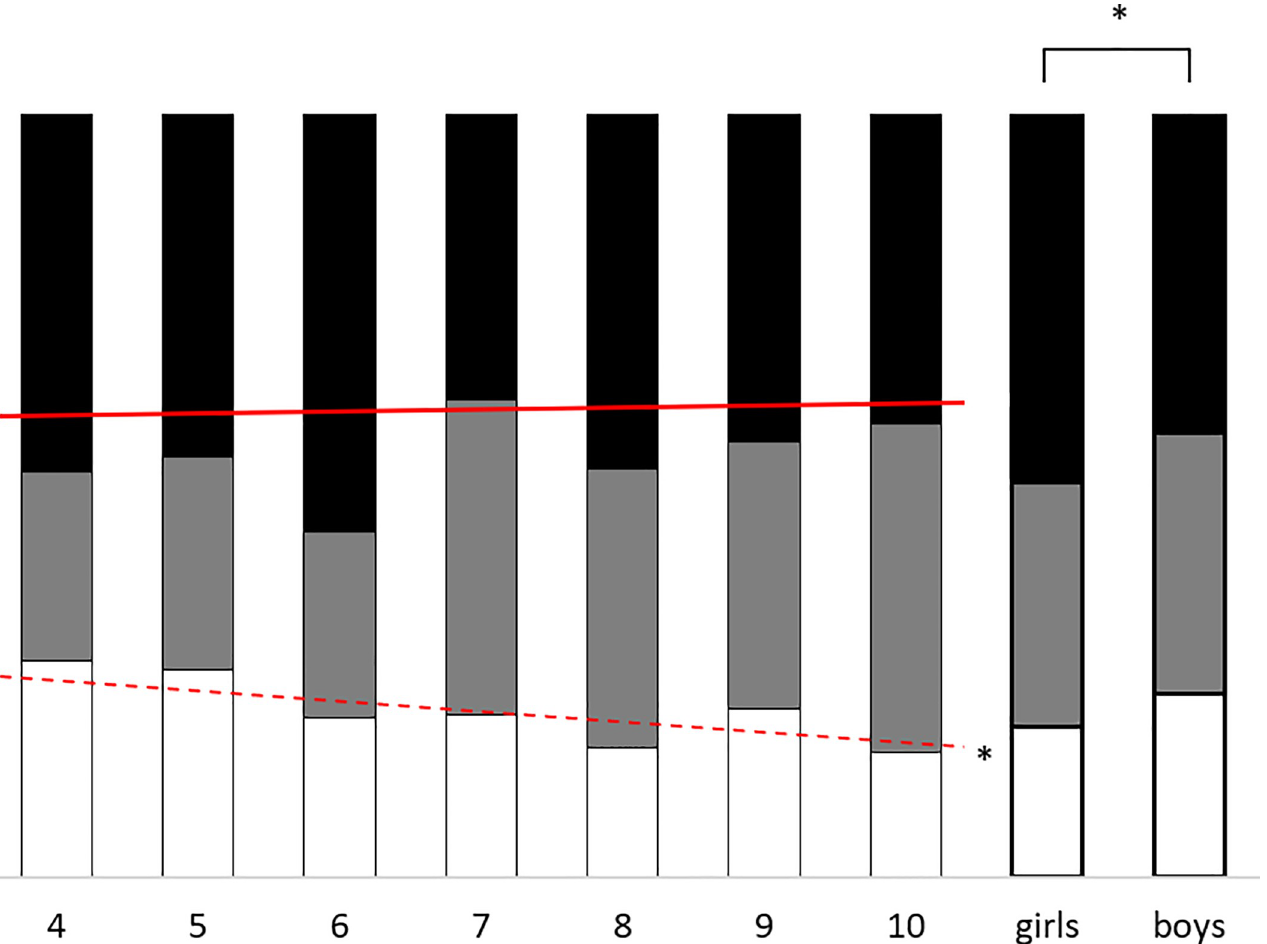
Fig 2. Summary of children’s overall levels of moral concern (collapsed over all 24 entities) across age groups and gender. White bars indicate the proportion of ‘not caring at all’ responses; grey bars indicate the proportion of ‘caring a little’ responses, and black bars indicate the proportion of ‘caring a lot’ responses. The solid red line indicates the (non-significant) linear effect of age. The dashed red line indicates the significant linear effect of age ( p < .001) on children’s ‘not caring at all responses’ (compared to the other two responses combined). Across entities, girls cared significantly more than boys ( p = .013).